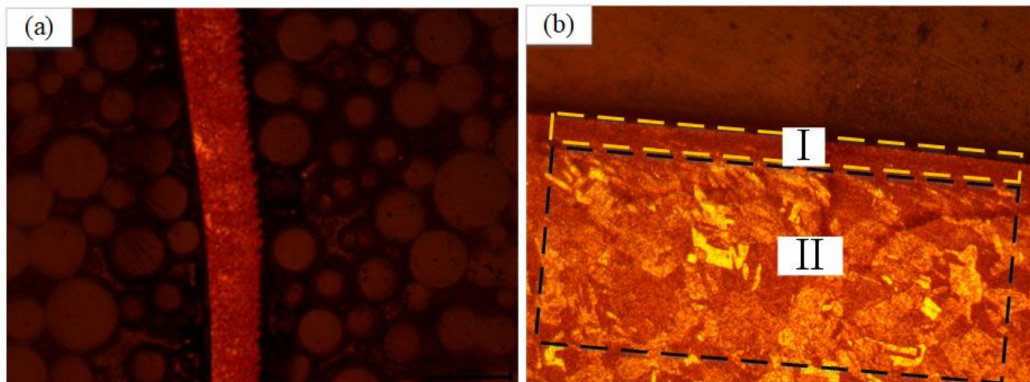
Figure 9. The microstructure of ( a ) the chip and ( b ) the machined